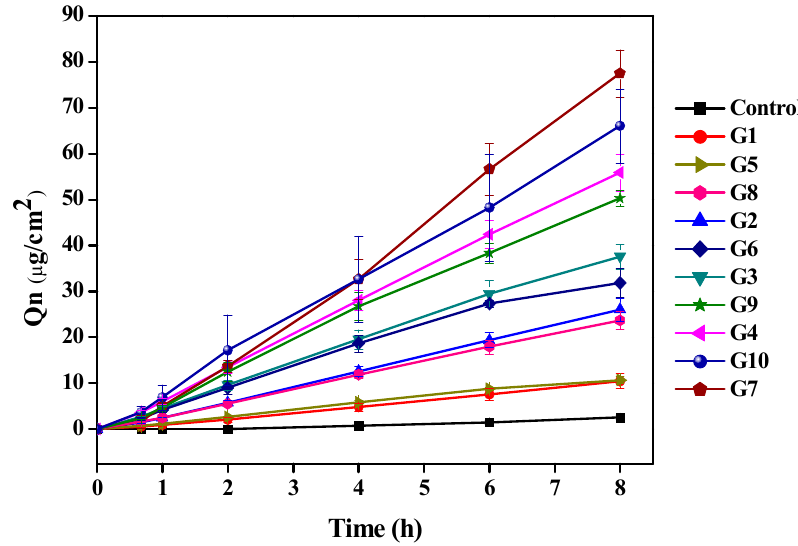
Figure 4. Cumulative ex vivo skin permeation for the TGP solution under different microneedle conditions (G1 through G10) ( n = 3).